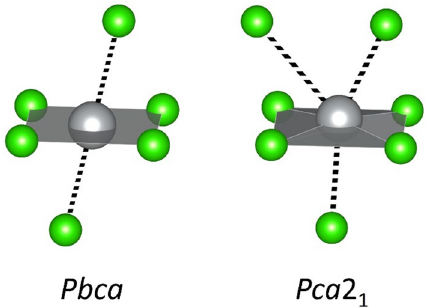
Figure 11. Comparison of local coordination of original and phonon-relaxed structures of AgF 2 -type at 10 GPa.